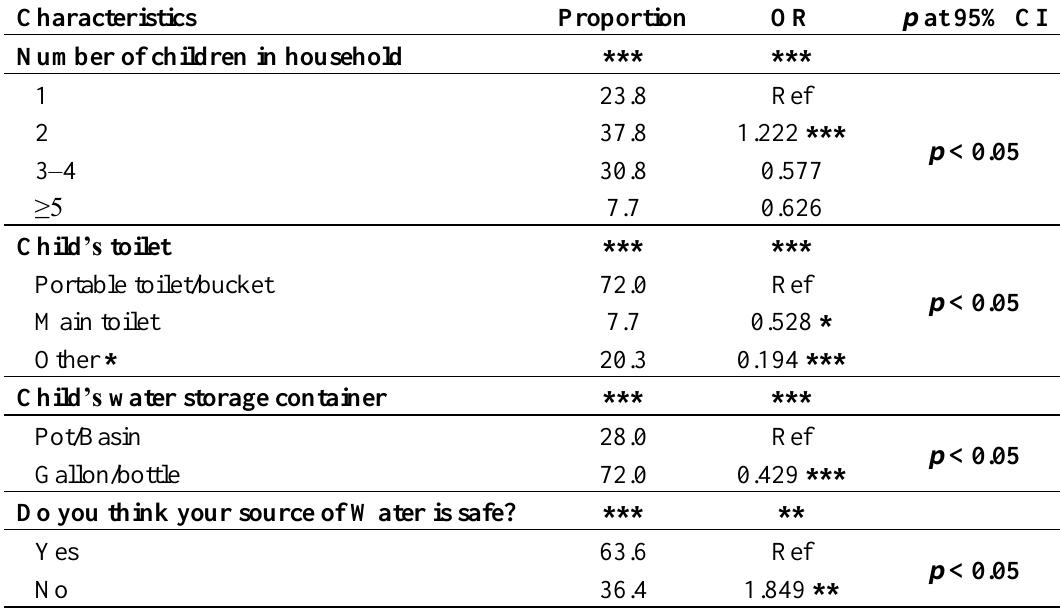
Table 4. The distribution of children less than five of age with Diarrhea according to their Environmental and behavioral characteristics in Tiko city